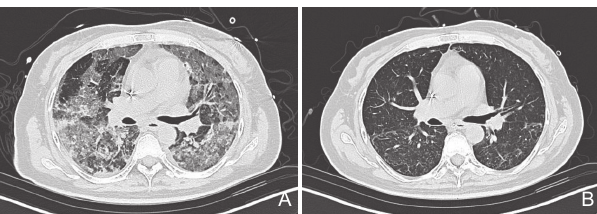
Figure 2 Chest CT images. (A) On the first day in the hospital, the CT images showed patchy high-density shadow, ground-glass opacity and consolidation with obscure margin. Air bronchogram appeared; (B) On the 24th day in the hospital, the CT images showed an obvious alleviation of the pulmonary